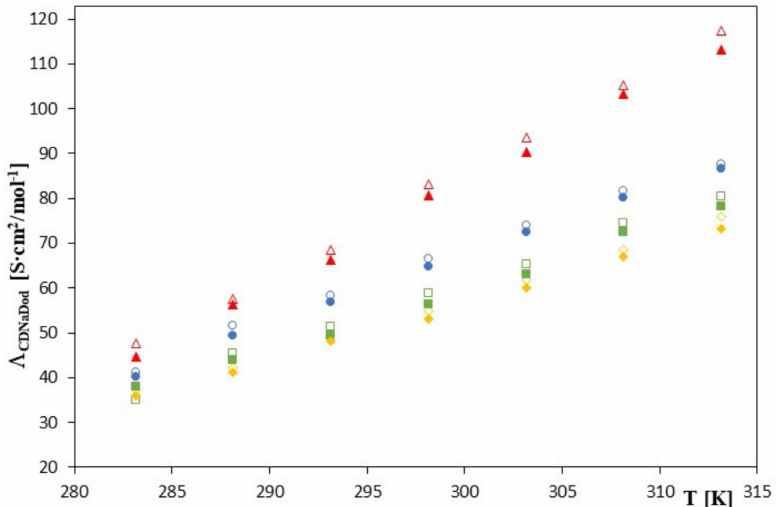
Figure 2. The plots of the dependence of the theoretical conductivity Λ CDNaDod [S · cm 2 /mol − 1 ] in the function T [K] for β -cyclodextrin with all studied salts.: - trans -cinnamic acid; - trans –p- coumaric acid; - trans -caffeic acid; - trans -ferulic acid and 2-HP- β -cyclodextrin with the studied salts.: - trans -cinnamic acid; - trans –p-coumaric acid; - trans -caffeic acid; - trans -ferulic